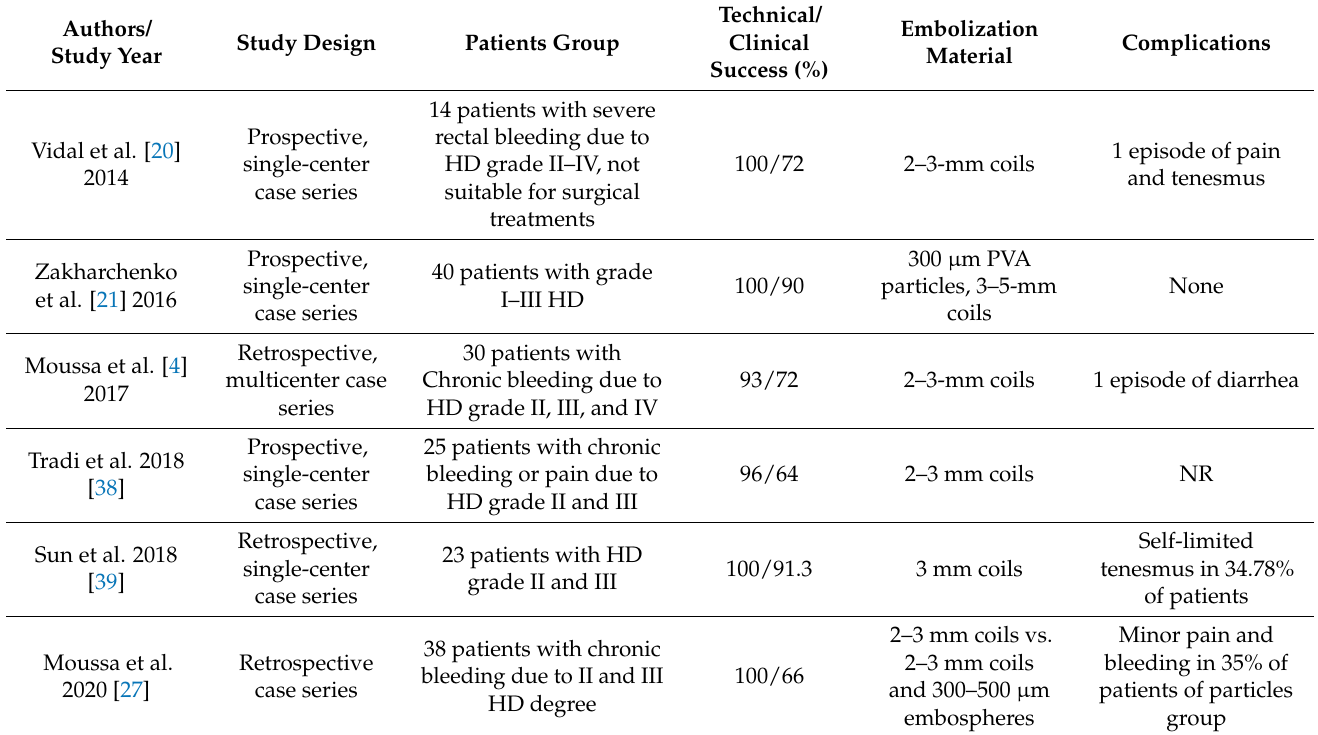
Table 6. Main studies on SRA